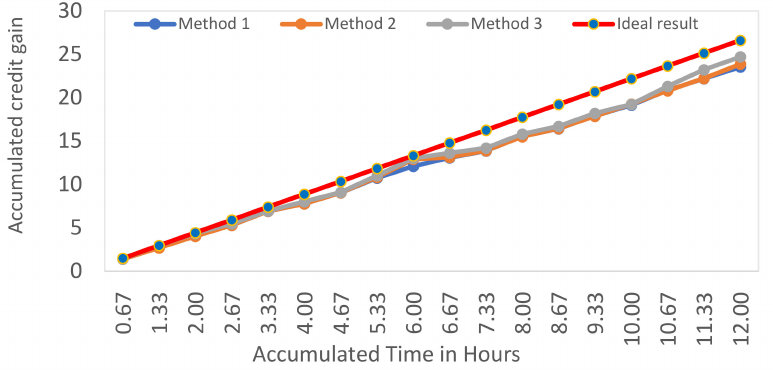
Figure 5. Comparison between the three methods for the accumulated credit gain for a six-week prehabilitation